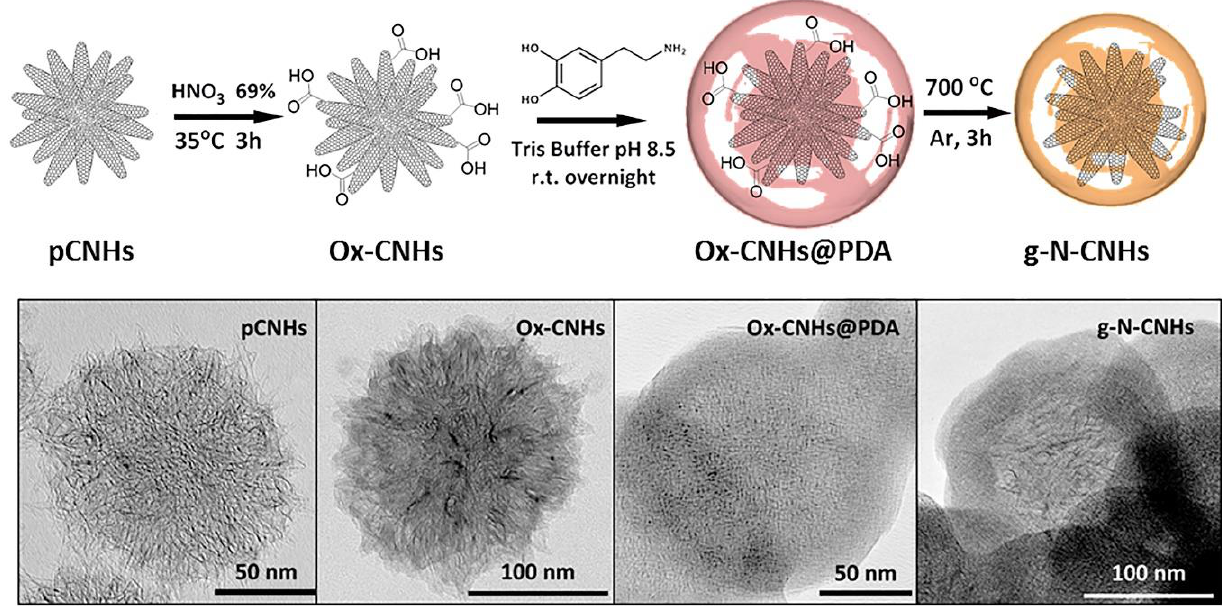
Figure 11. Synthesis of N-doped graphitized carbon nanohorns and TEM images at each stage of the synthesis [261].